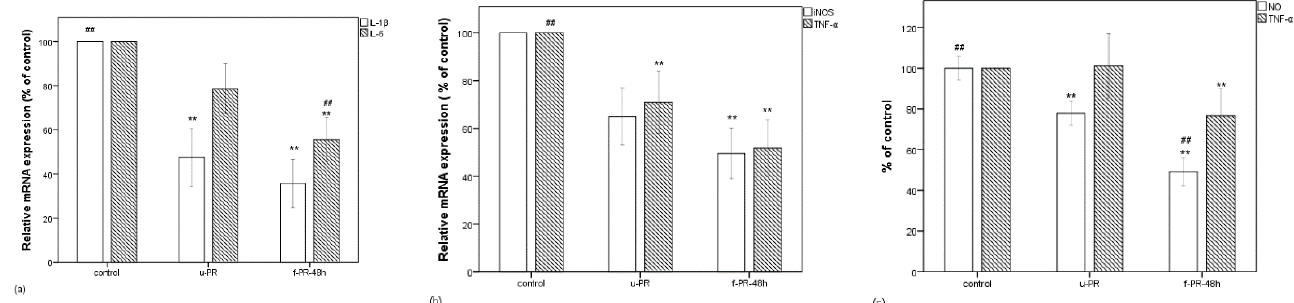
Figure 2. ( a ) Decrease in the mRNA expressions of IL-6 and IL-1 β (in % of control) in LPS-stimulated RAW 264.7 cells, which were treated with unfermented PR extract and the PR extract fermented for 48 h. ( b ) Decrease in the mRNA expressions of iNOS and TNF- α (in % of control). ( c ) Decrease in NO and TNF- α levels (in % of control). Data are expressed as the mean value of at least triplicate experiments. Error bars represent +/ − standard deviation. ** p < 0.01 versus control, ## p < 0.01 versus u-PR. u-PR: PR extract without fermentation; f-PR-48h: PR extract fermented for 48 h.